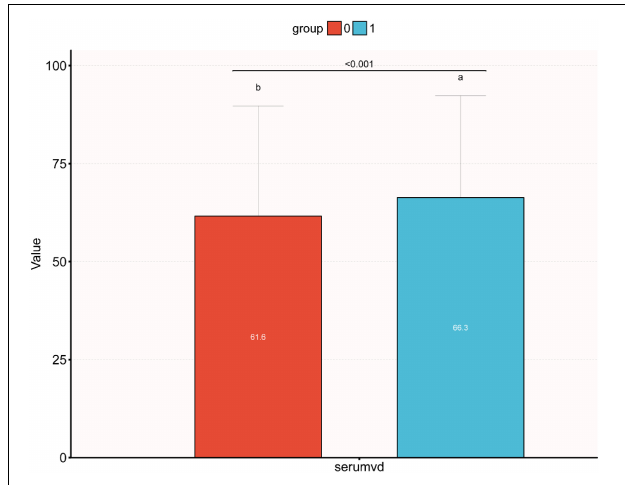
FIGURE 2 | Bar figure of the differences between different vitamin D levels in the high and low dietary magnesium intake groups. Median vitamin D levels were significantly higher in the high magnesium intake group than in the low dietary magnesium intake group (0: low dietary magnesium intake group, 1: high dietary magnesium intake group, 66.3 vs. 61.6 nmol/L, p <